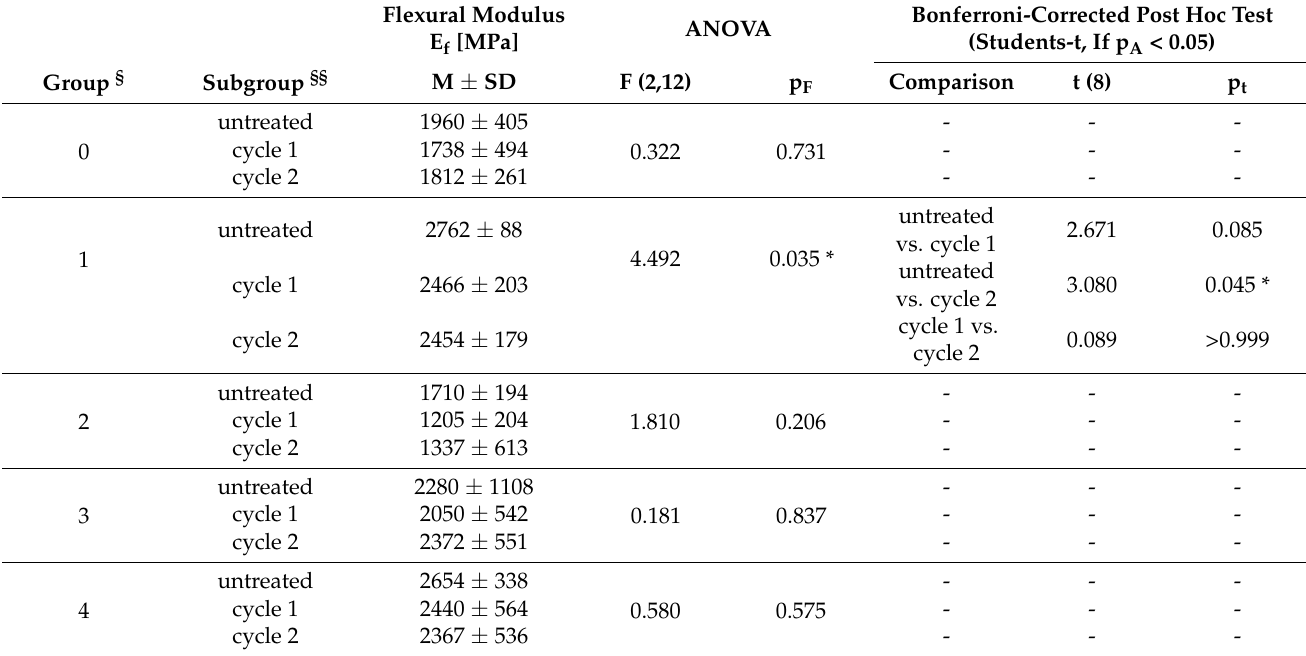
Table 3. Results of the three-point bending test and statistical